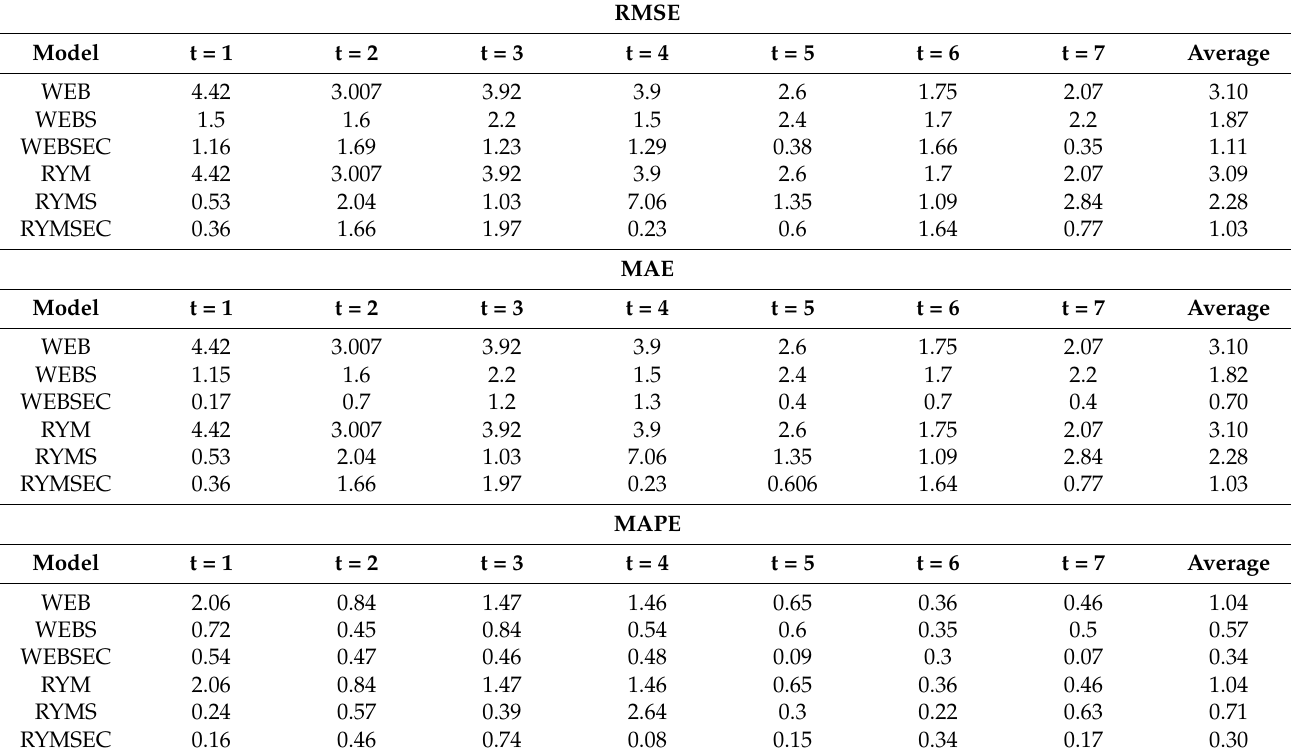
Table 5. Performance results of different WSP models for Arizona Hills